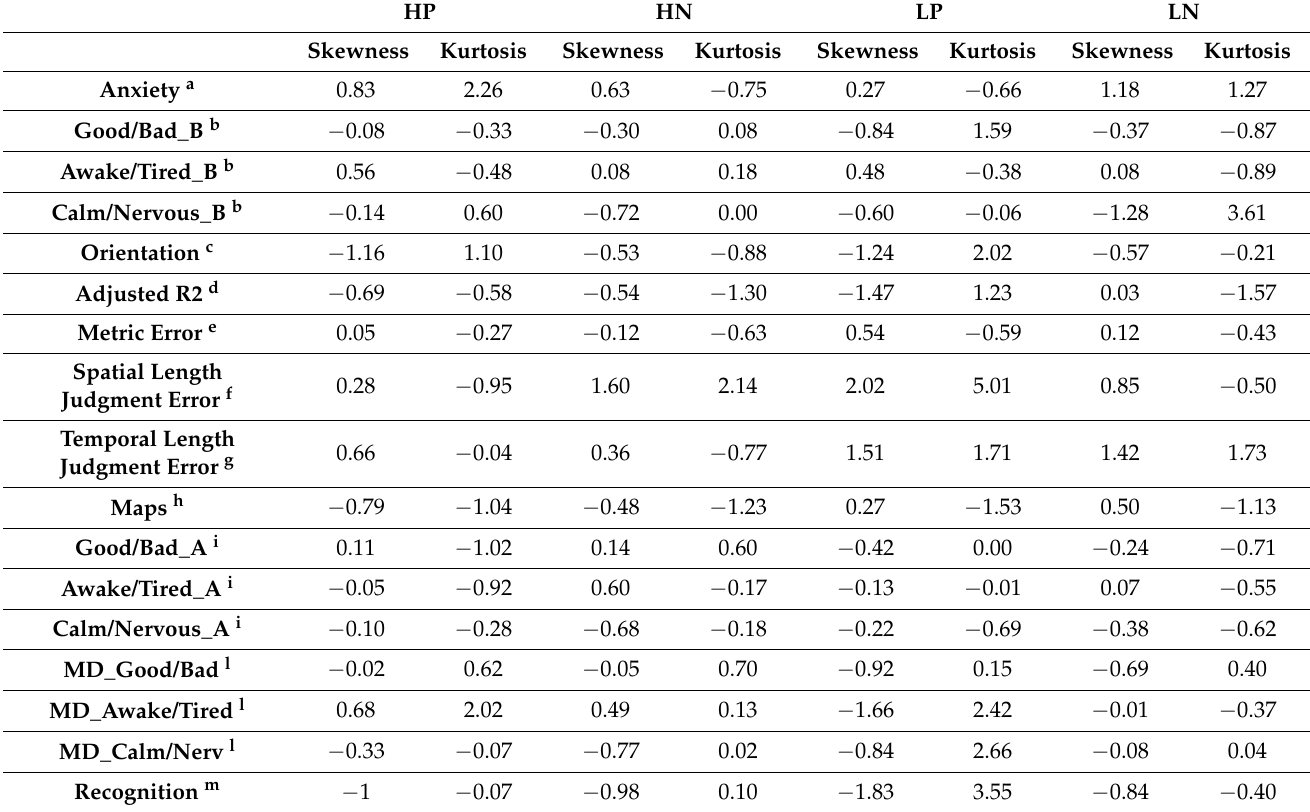
Table A1. Skewness and kurtosis values of all the measures included in the